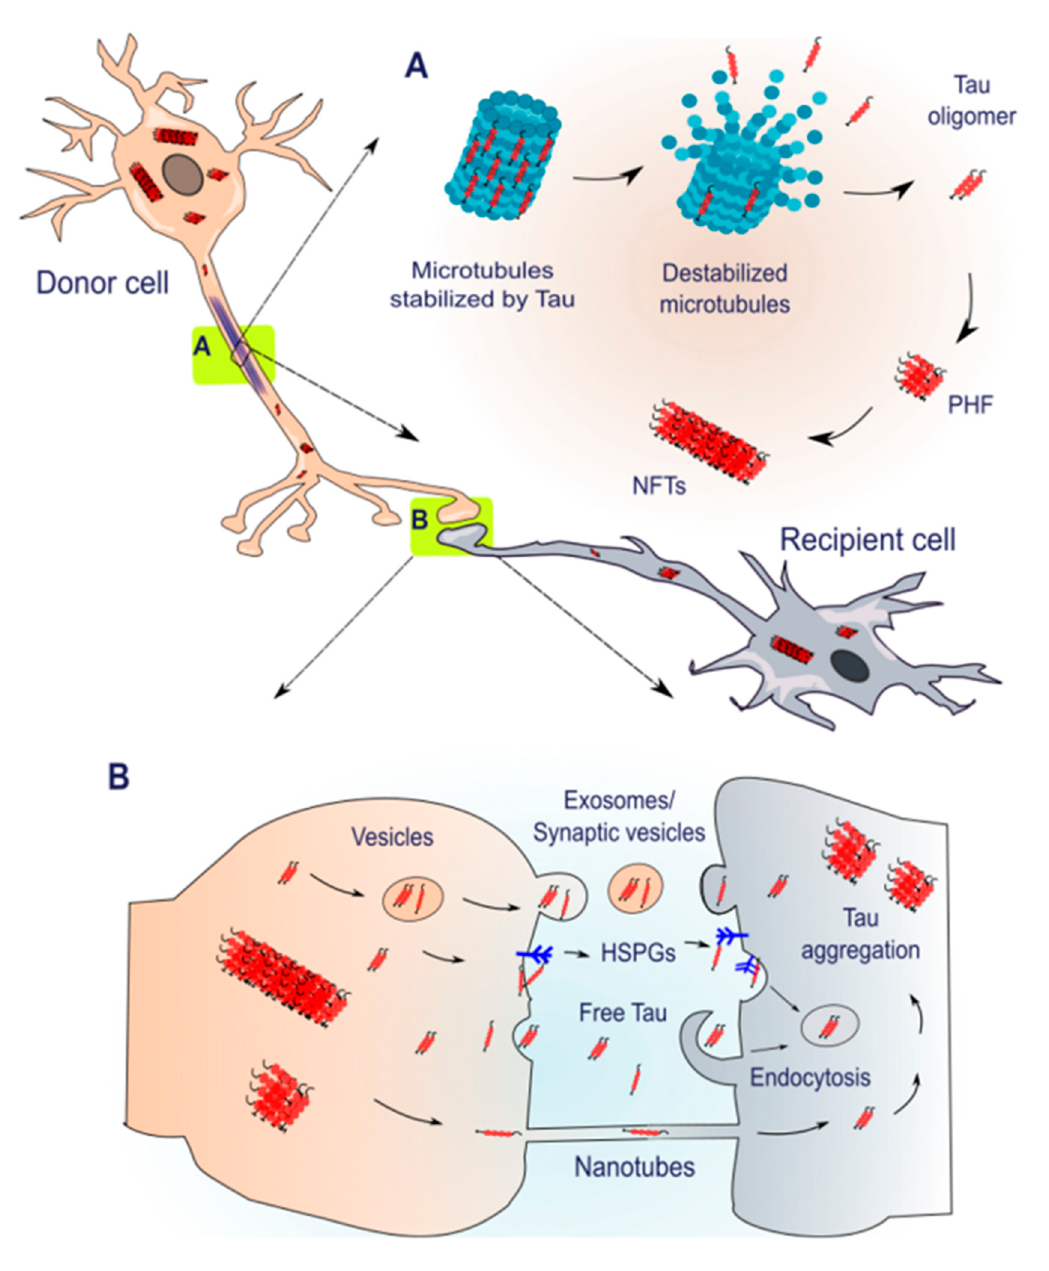
Figure 1. Tau aggregation and spreading. ( A ) Tau stabilizes microtubules and contributes to the maintenance of axonal shape and neuronal morphology. In pathological conditions, tau is subjected to various posttranslational modifications (PTMs) that reduce microtubule binding and, thereby, promote the generation of insoluble tau. Soluble monomers form oligomers which aggregate to generate paired helical filaments (PHFs). These, in turn, assemble to produce neurofibrillary tangles (NFTs). ( B ) Possible mechanisms involved in the cell-to-cell transmission of pathological tau. Transmission may occur via direct translocation across the plasma membrane, via exosomes/synaptic vesicles, by clustering with the plasma membrane and interaction with the cell Heparan sulfate proteoglycans (HSPGs), and through cytoplasmic bridges called tunneling nanotubes. Uptake from the extracellular space can be mediated by binding and internalization with HSPGs or through endocytosis.